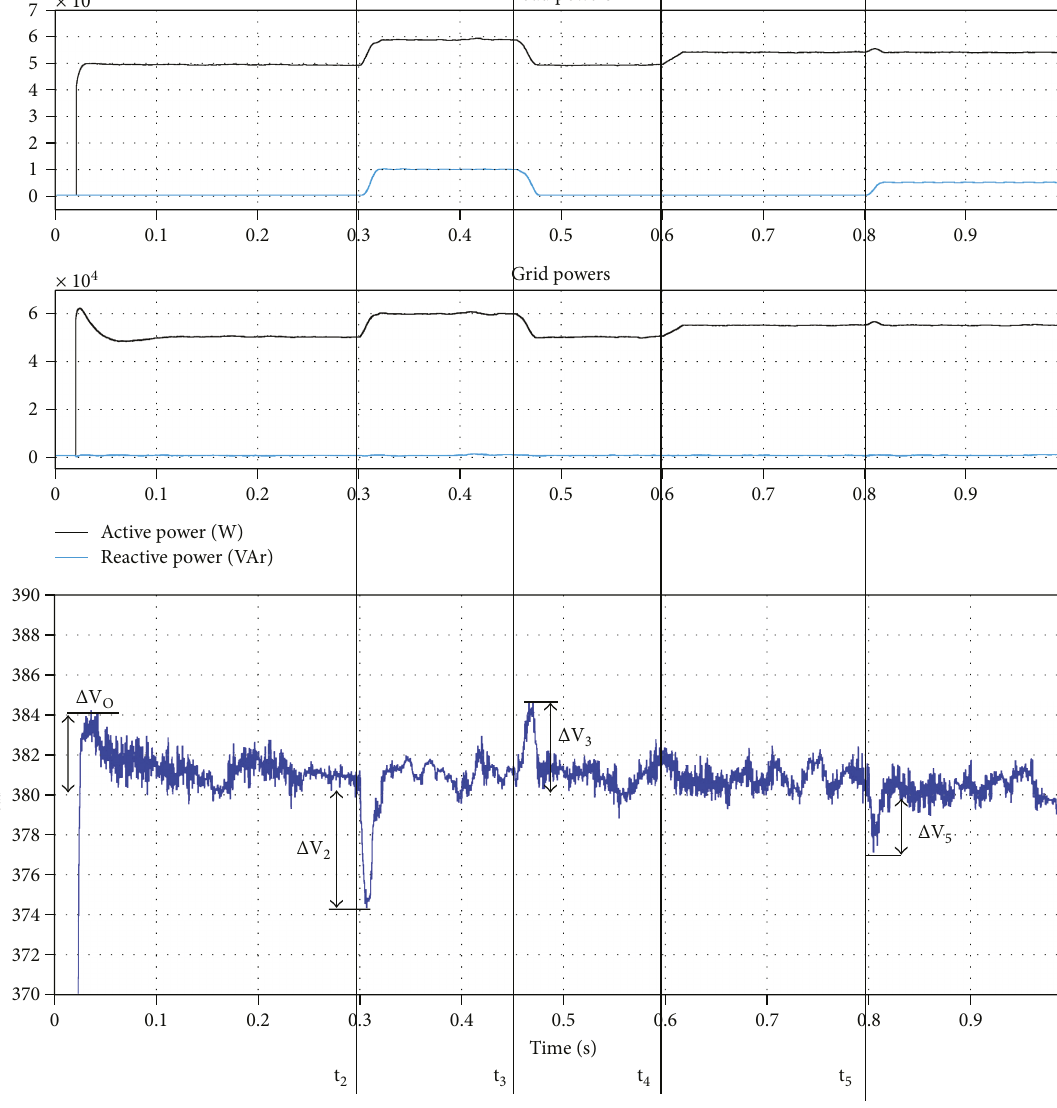
Figure 16: Reactive power compensation when the STATCOM device with a PI λ -MPC hybrid controller is enabled and load voltage